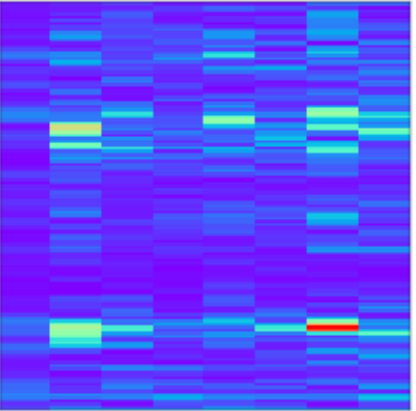
Figure 3. Image of STFT-based time–frequency domain input